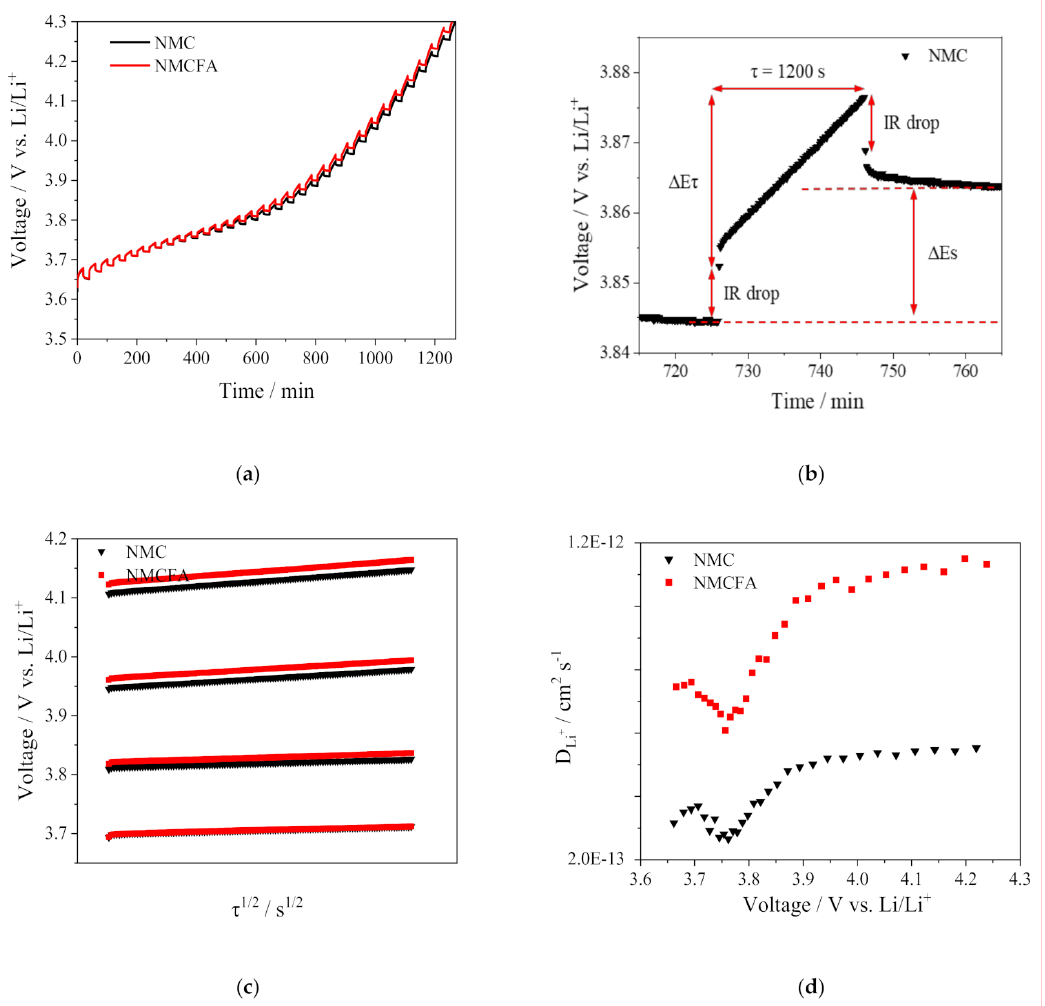
Figure 7. ( a ) GITT curves of NMC and NMCFA during the charge process at a current density of 0.1 C in the voltage range between 3.0 and 4.3 V. ( b ) GITT curve at a single titration of NMC. ( c ) Linear behavior in the relationship of E vs. the whole voltage range. ( d ) Lithium-ion diffusion coefficients of NMC and NMCFA calculated from the GITT curves as a function of the cell